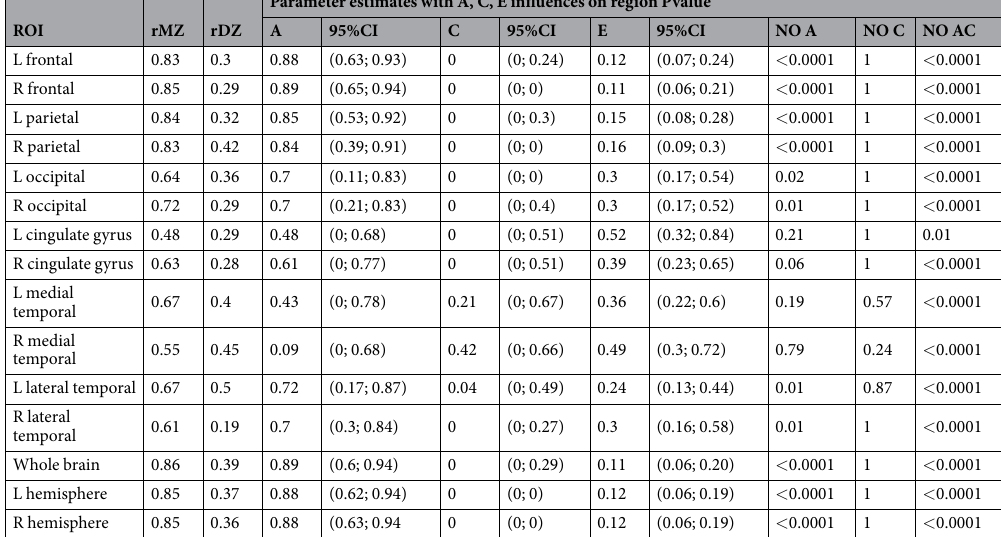
Table 1. Correlation coefficient and model fitness of each brain region. The whole brain is divided into 12 brain region, A: additive genetic effects; C: common environmental effects; E: individual-specific environmental effects. CI: confidence interval. No A: CE model, hypothesis: there is no additive genetic effects; no C: AE model, hypothesis: there is no common environmental effects; no AC: E model, hypothesis: there is only individual-specific environmental